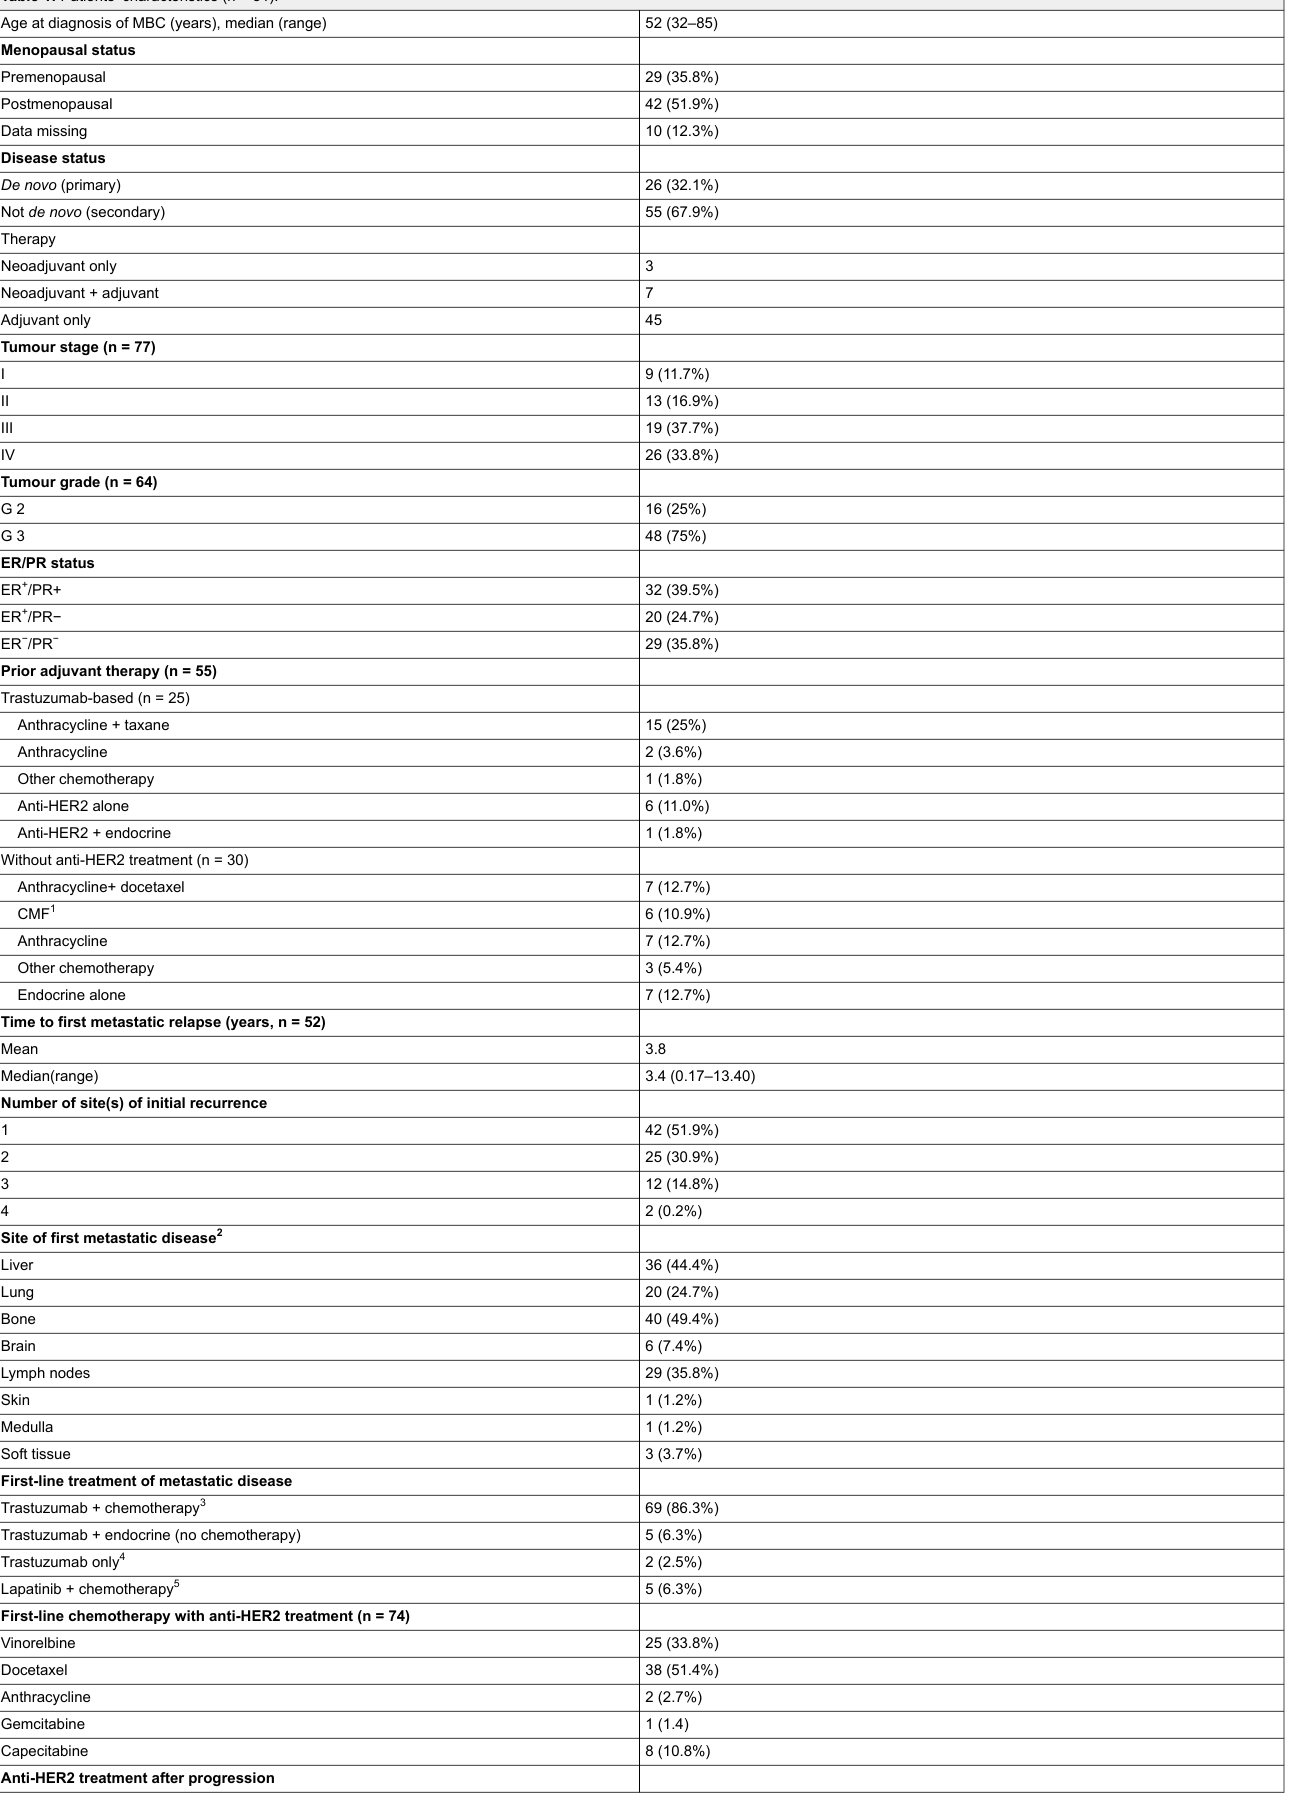
Table 1: Patients’ characteristics (n = 81). Age at diagnosis of MBC (years), median